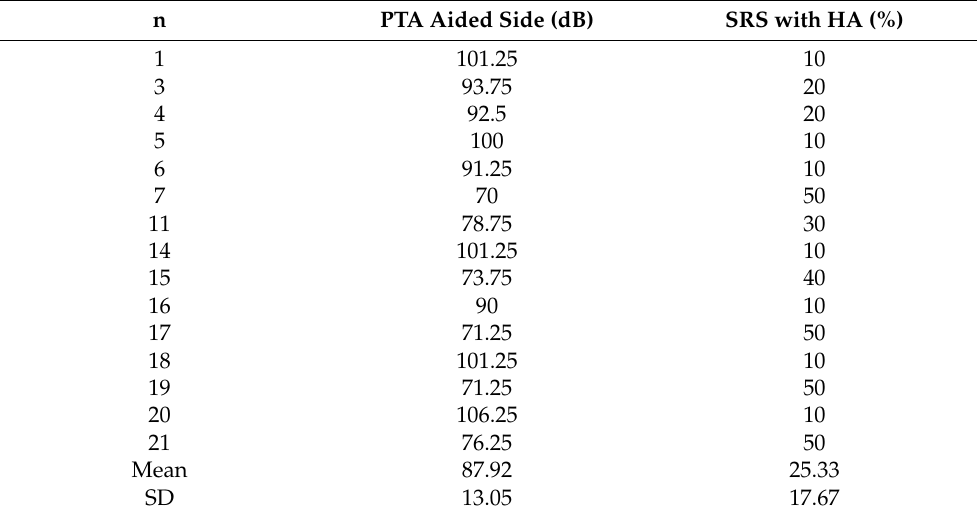
Table 2. Audiometric data of non-implanted ears in bimodal